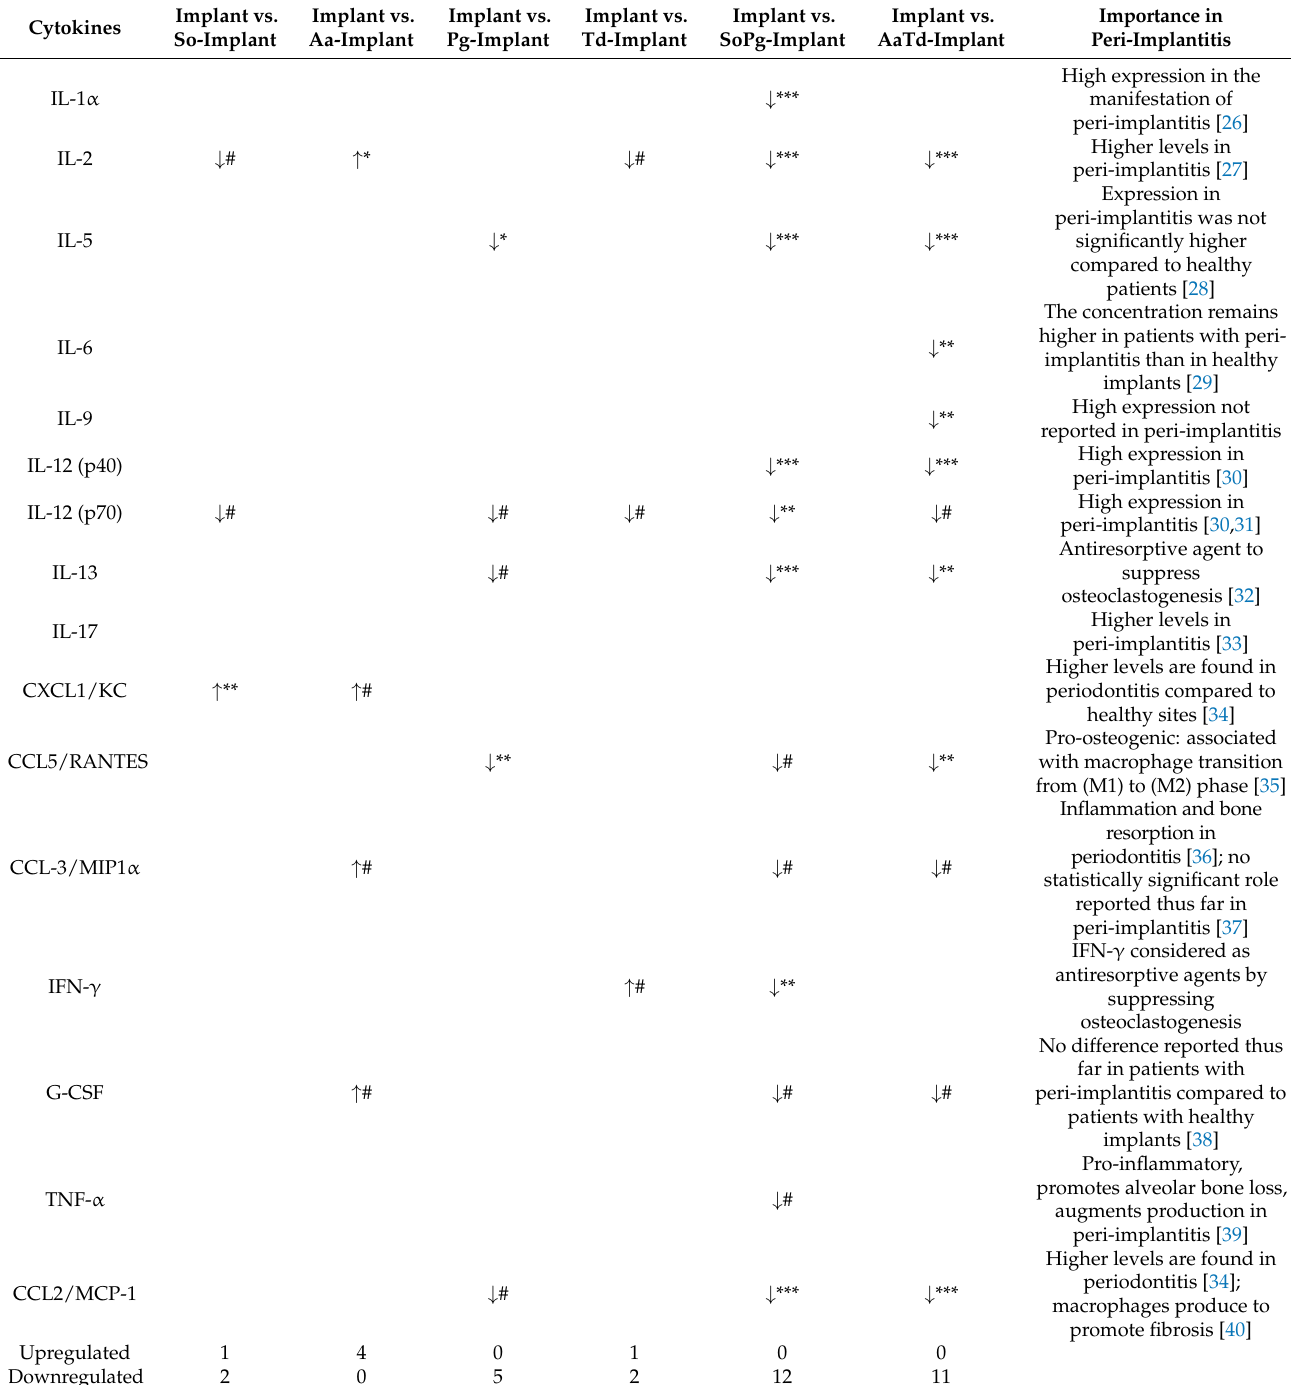
Table 1. Effect of the single species or dual species bacterial infections around implants and status of inflammatory cytokine secretion. Symbols ***, **, *, and # indicate p < 0.001, p < 0.01, p < 0.05, and significant p -value prior to Bonferroni correction, respectively. ( ↑ ) indicate increase in the expression of cytokines, ( ↓ ) indicate decrease in the expression of